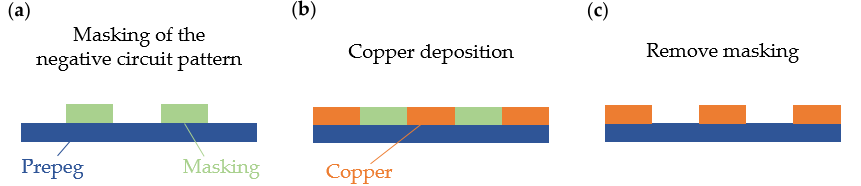
Figure 3. Additive technology ( a ) masking of the negative circuit pattern ( b ) copper deposition ( c ) removing masking.